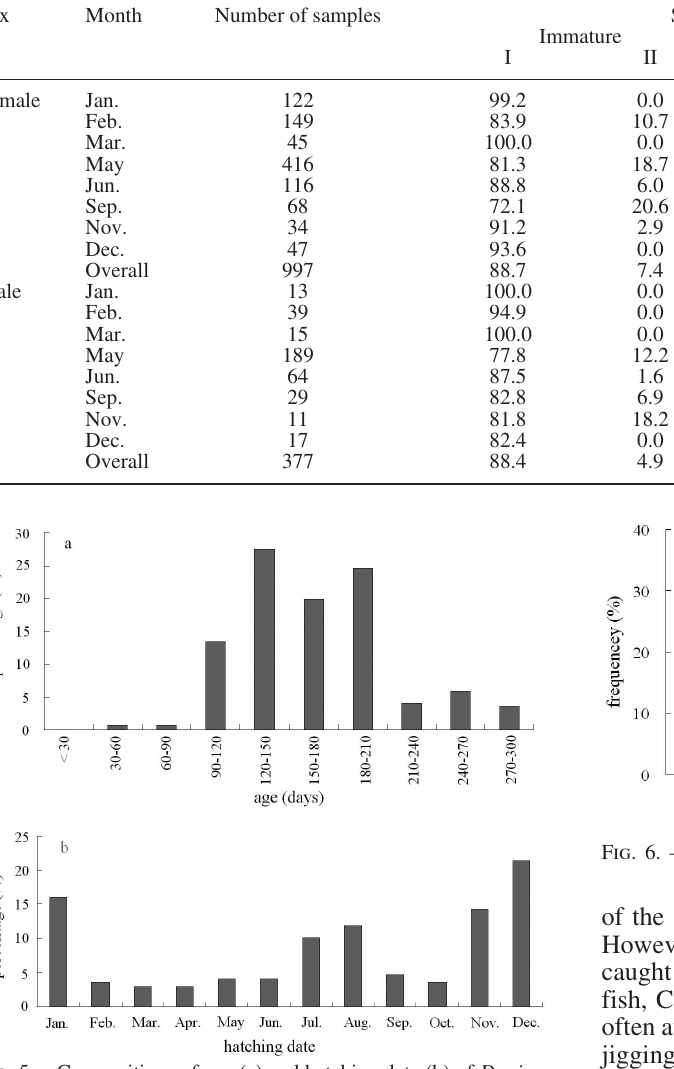
Fig . 5. – Compositions of age (a) and hatching date (b) of D. gigas off Chile.